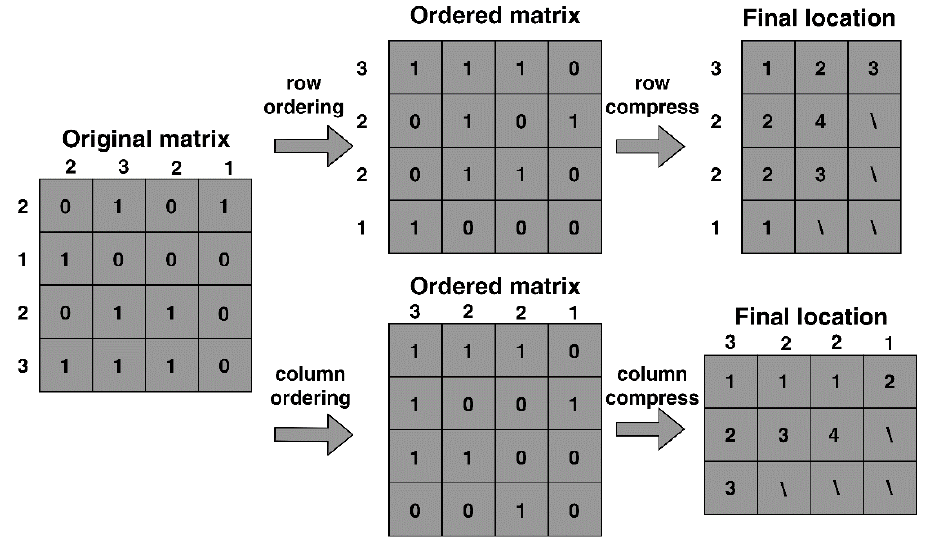
Figure 9. The compression process of PCM.